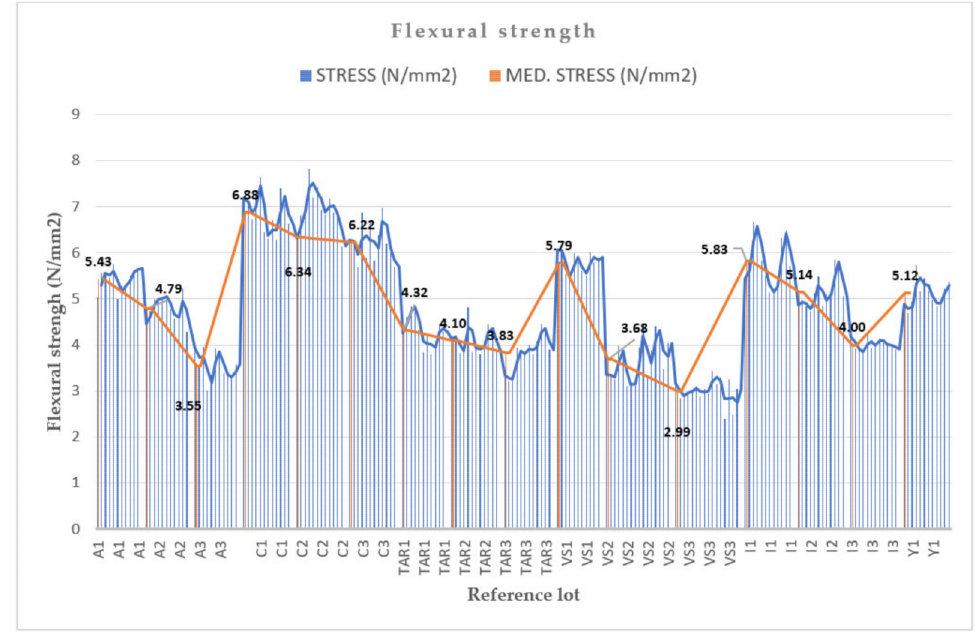
Scheme 2. Flexural strength values (N/mm 2 ) for the different tests and